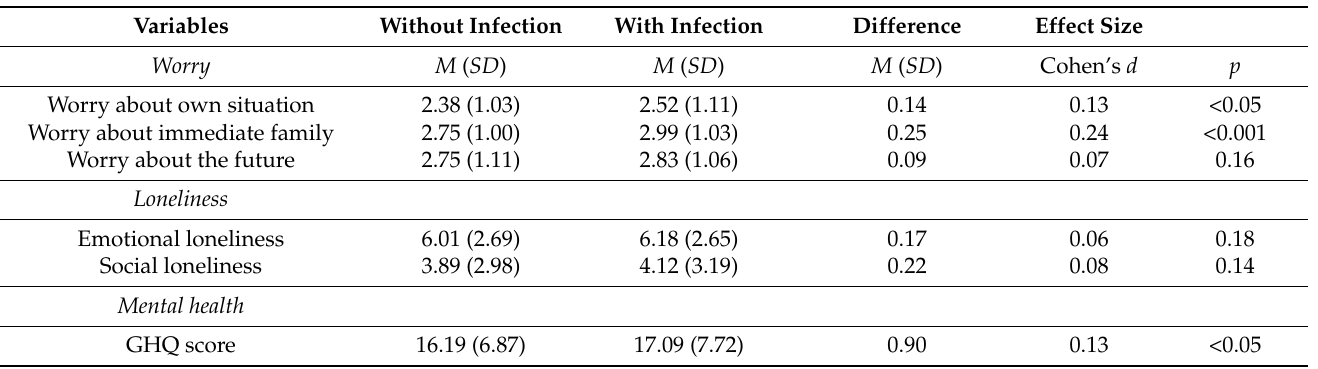
Table 2. Worry, loneliness, and mental health among participants with and without COVID-19 infection.